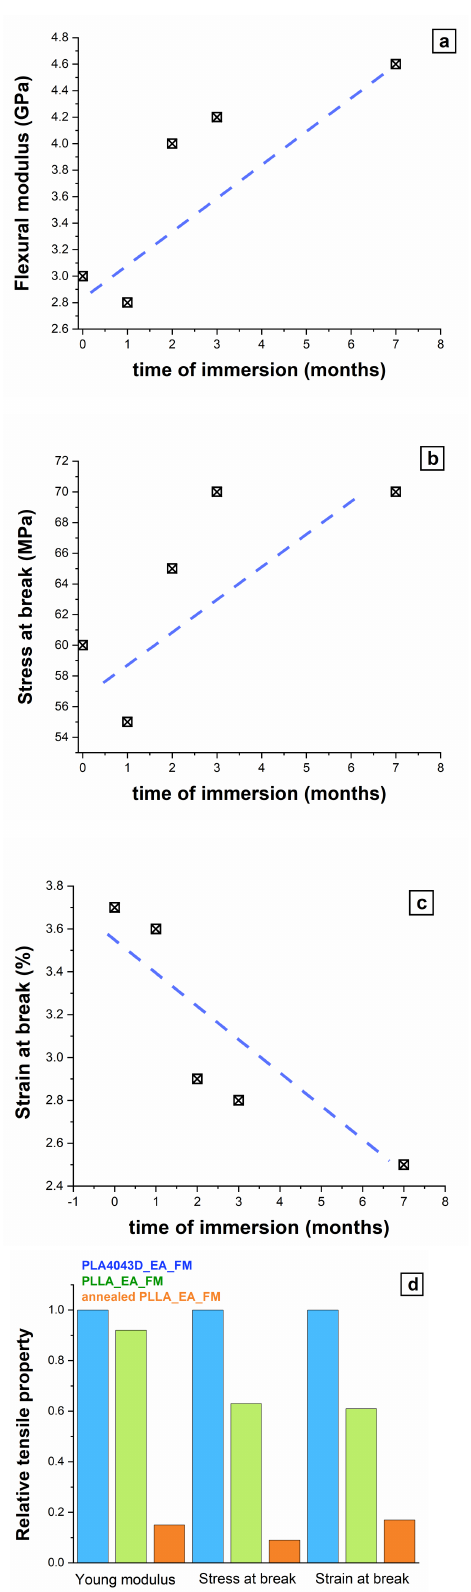
Figure 6. Flexural modulus ( a ), stress at break ( b ), and strain at break ( c ) from flexural tests, as a function of the immersion time. ( d ) Relative tensile properties of the 7-month immersed materials calculated by the ratio between any mechanical property of the biocomposite and the same mechanical property of